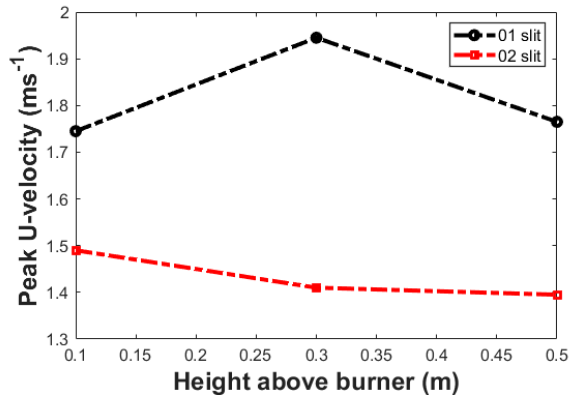
Figure 8. Peak value of U-velocity of the two cases, at all monitoring HABs.